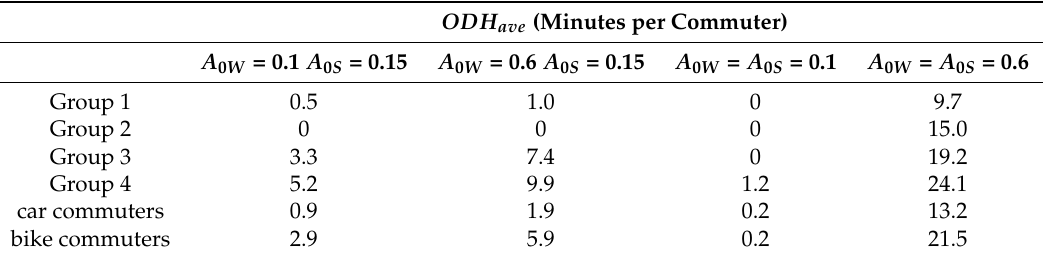
Figure 12. Difference in the averaged T mrt of simulations with different albedo A 0 minus the simulation with A 0 = 0.1. Solid lines correspond to results where only A 0 of the walls are changed ( A 0 of streets is set to 0.15) and dashed lines to results where A 0 of the walls as well as the A 0 of the streets are changed. All other parameters are taken from the reference case (Tables 1 and 2). Table 3. Averaged time exposed to heat stress ( ODH ave ) of different groups for different albedo values. All other parameters are taken from the reference case (Table 1).